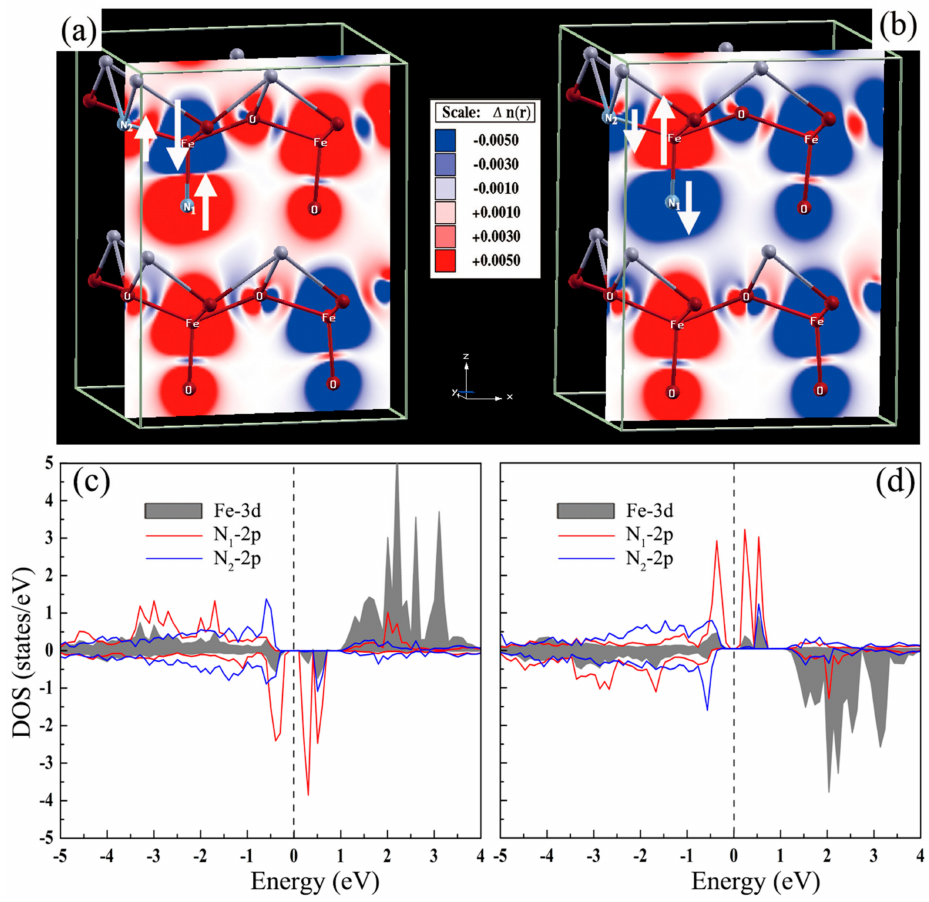
Figure 2. Spin-density distribution of ( a ) G-AFM and ( b ) C-AFM orderings in N-doped tetragonal BFO supercell. ( c , d ) The partial DOS of Fe and N ions corresponding to ( a , b ), respectively. The red and blue regions denote the spin-up and spin-down charge densities,